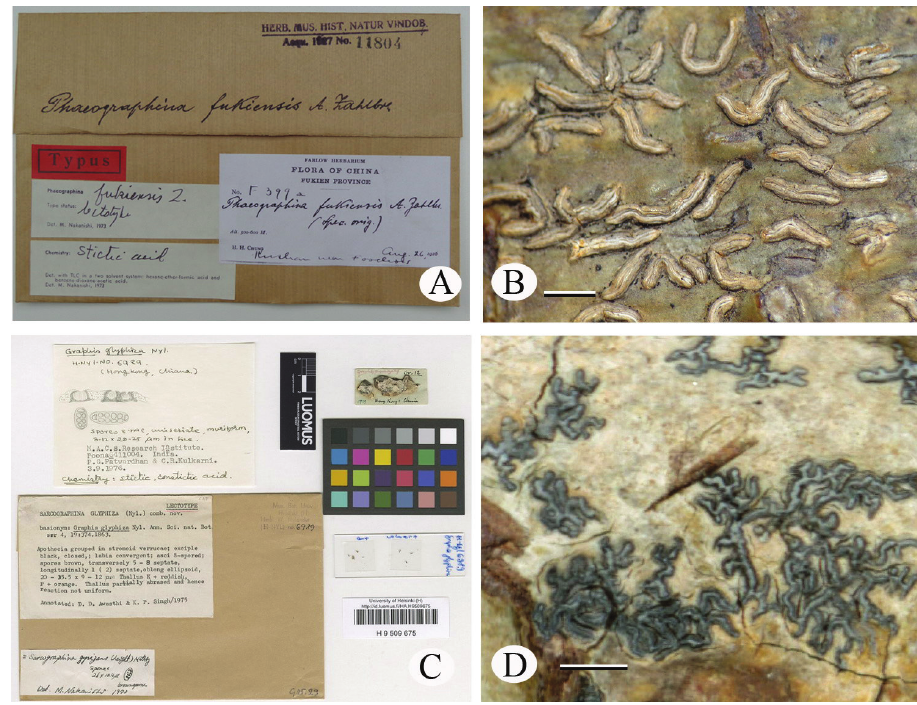
Figure 2. A–B Phaeographina fukiensis Zahlbr. ( Chung 399a ) C–D Graphis glyphiza Nyl. ( Nylander 6989 ). Scale bars =